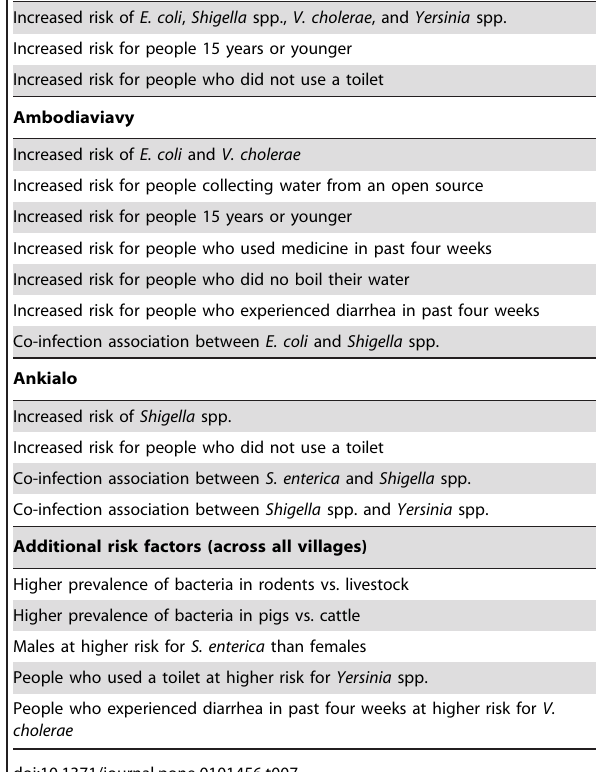
Table 7. Summary of significant findings for infection with Enterobacteriaceae in human, livestock, and rodent